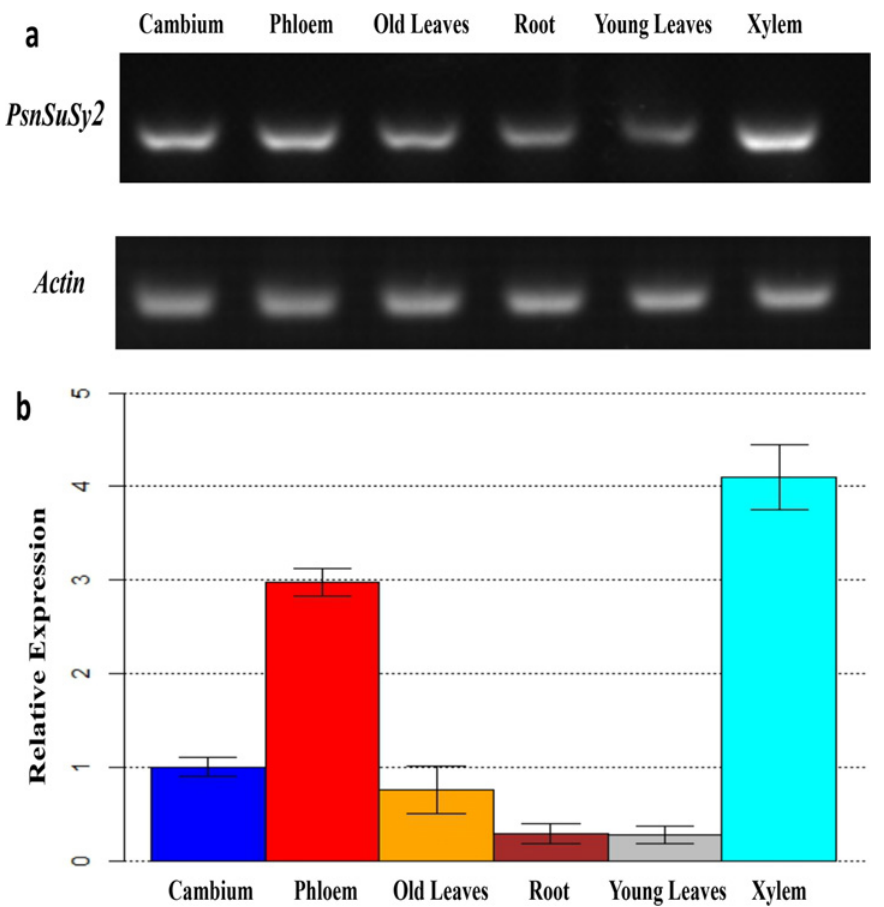
Fig 2. Tissue-specific expression of the PsnSuSy2 in one-year-old hybrid Populus simonii × Populus nigra propagated from two years old hybrid trees. a. Tissue-specific expression pattern characterized by RT-PCR. b. Tissue-specific expression pattern characterized by real-time quantitative PCR. The expression levels for real-time quantitative PCR were averaged from three replicates.